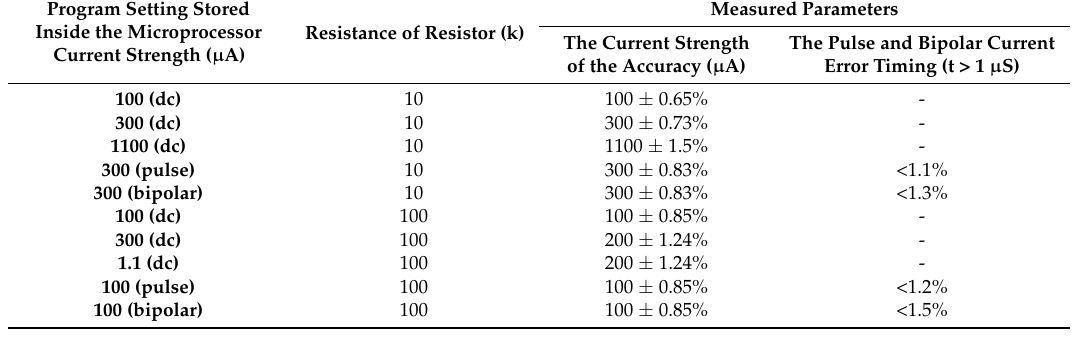
Table 3. The results (mean ± SD) of simulated accuracy of the variable current source at two different load resistors.